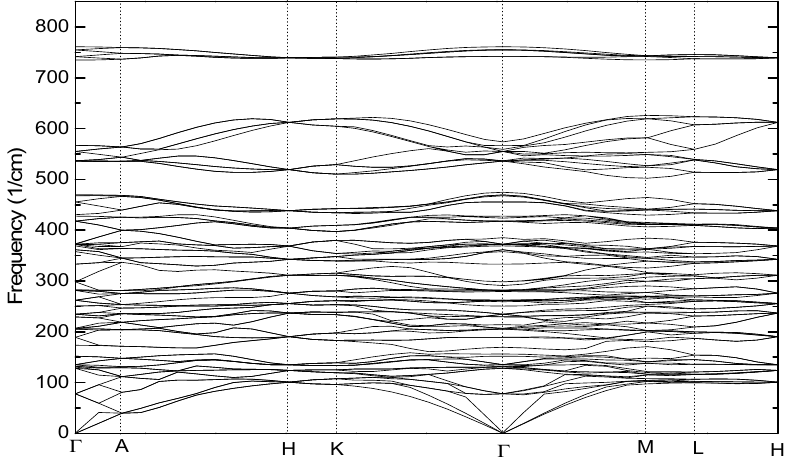
Figure 7. The phonon dispersion relations of the LN-type ZnTiO 3 (space group R3c) along high symmetry directions based on GGA.